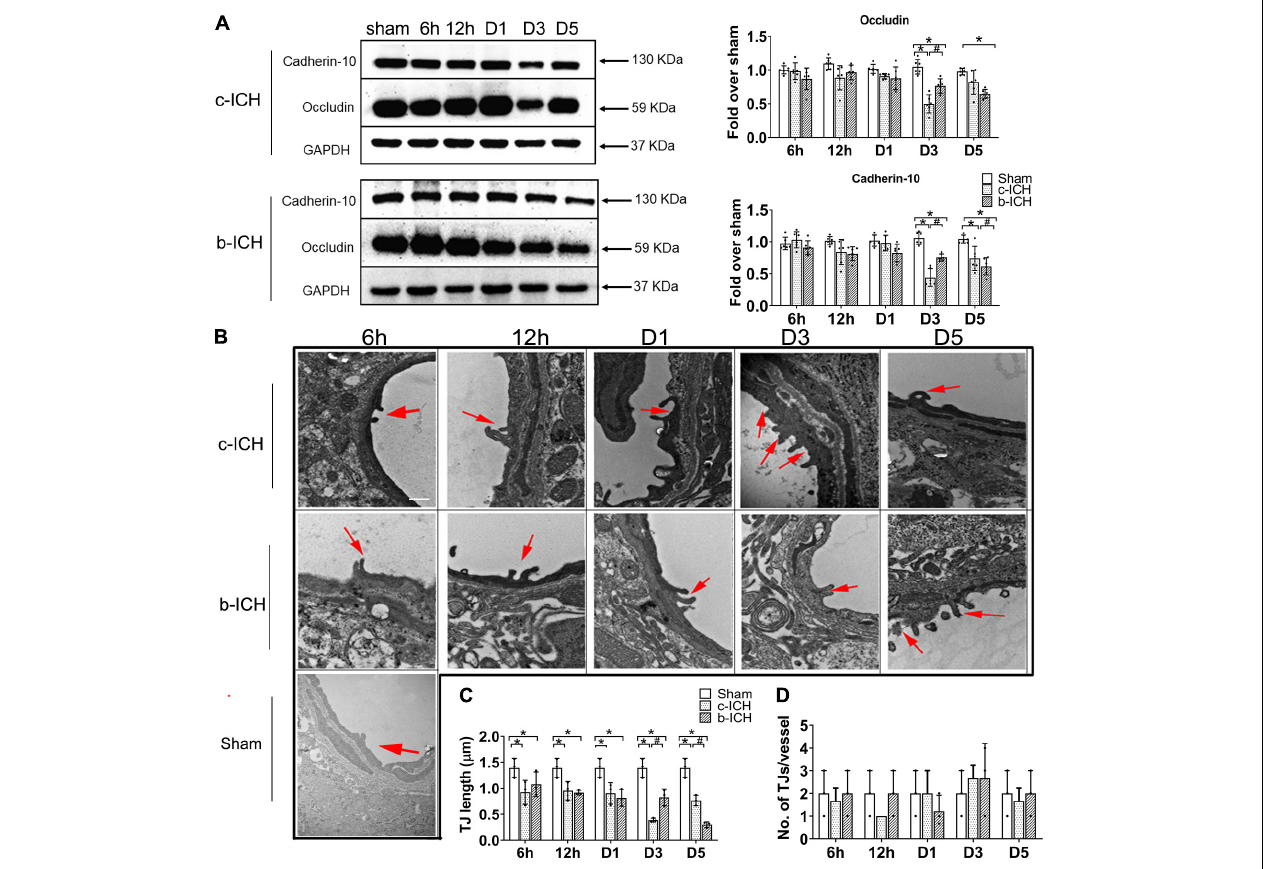
FIGURE 4 | The comparison of the expressions of tight junction proteins between c-ICH and b-ICH groups. (A) Western blots showed occludin expression and cadherin-10 expression at 6 h, 12 h, days 1, 3, and 5 after ICH. Quantification of occluding and cadherin-10 levels at 6 h, 12 h, day 1, day 3, and day 5 after ICH in both models ( n = 6 mice/group; * P < 0.05 vs. sham group, # P < 0.05 vs. c-ICH group; repeated measures ANOVA followed by Bonferroni post-hoc test). Values are mean ± SD. (B) Representative electron microscopic images of TJ ultrastructure at 6 h, 12 h, day 1, day 3, and day 5 after ICH in both models and sham group. Arrowheads = tight junctions (TJ); Scale bar = 1 µ M. (C) Quantification of tight junction length ( n = 3/group). (D) Quantification of the number of tight junctions per vessel ( n = 3 mice/group, four image fields quantified per mouse; * P < 0.05 vs. sham group, # P < 0.05 vs. c-ICH group (the repeated measures ANOVA followed by the Bonferroni post-hoc test). Values are mean ±